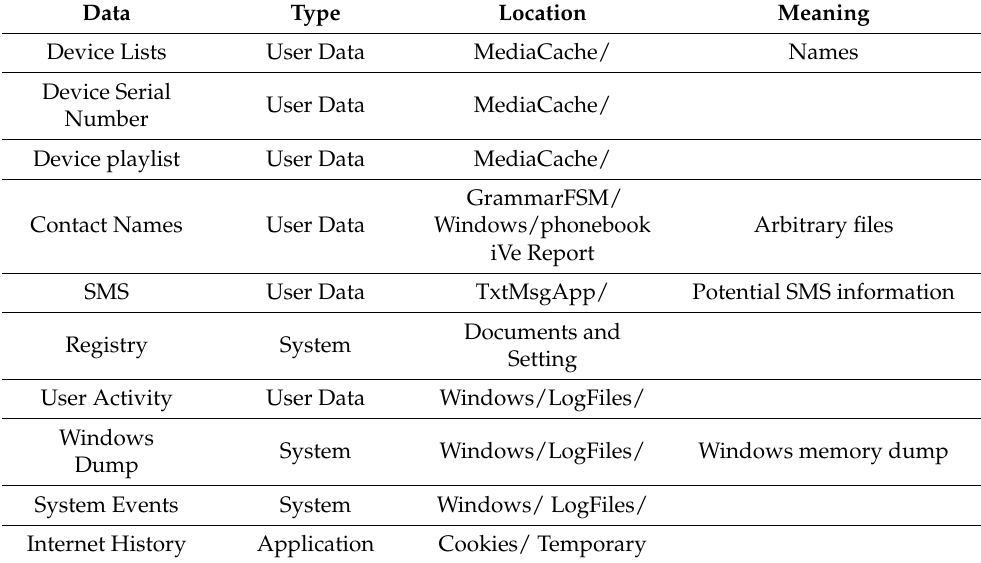
Table 1. Forensic data of